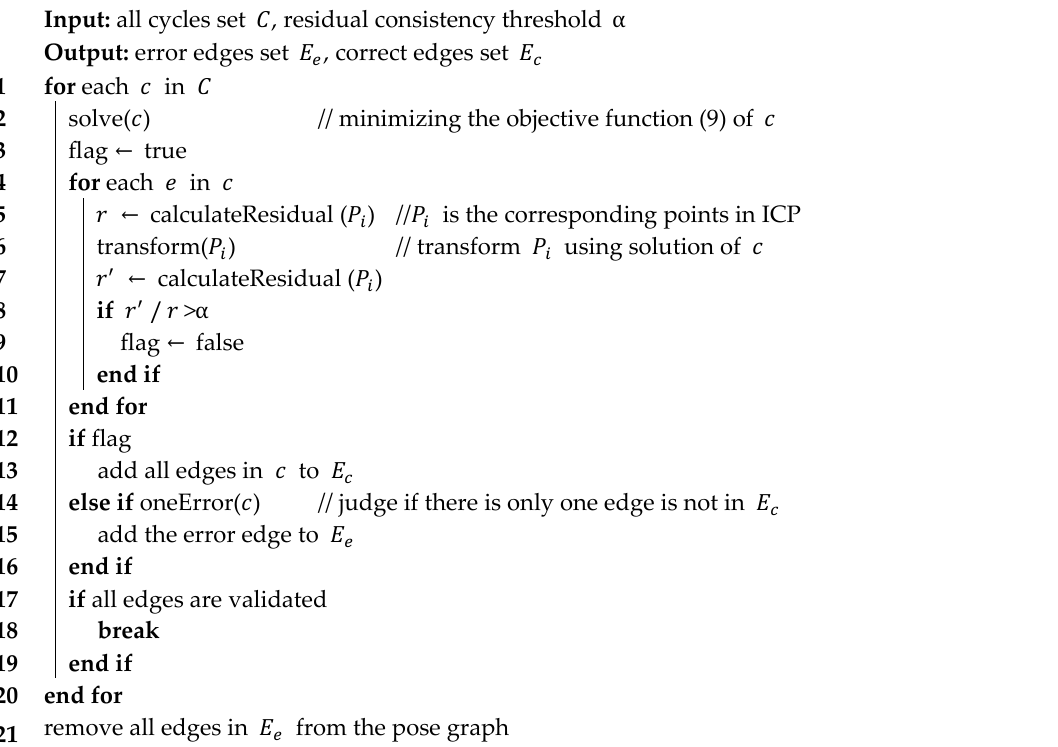
Algorithm 2: Cycle based error edge elimination